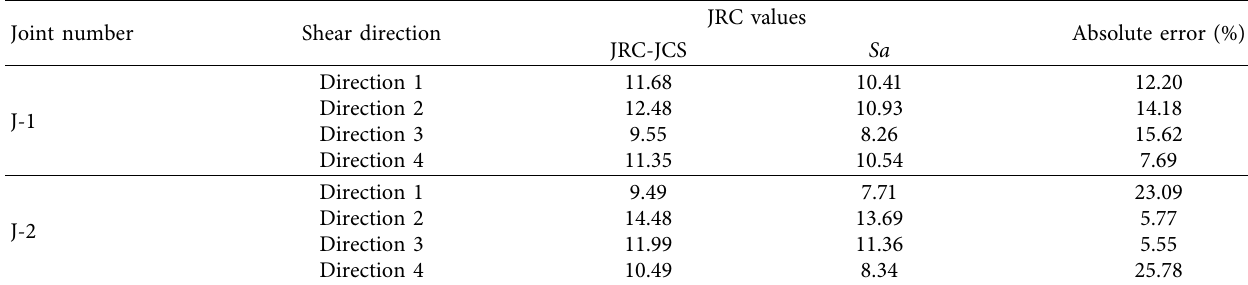
Table 8: Comparison of JRC results predicted by Sa and backcalculated by JRC-JCS model. Joint